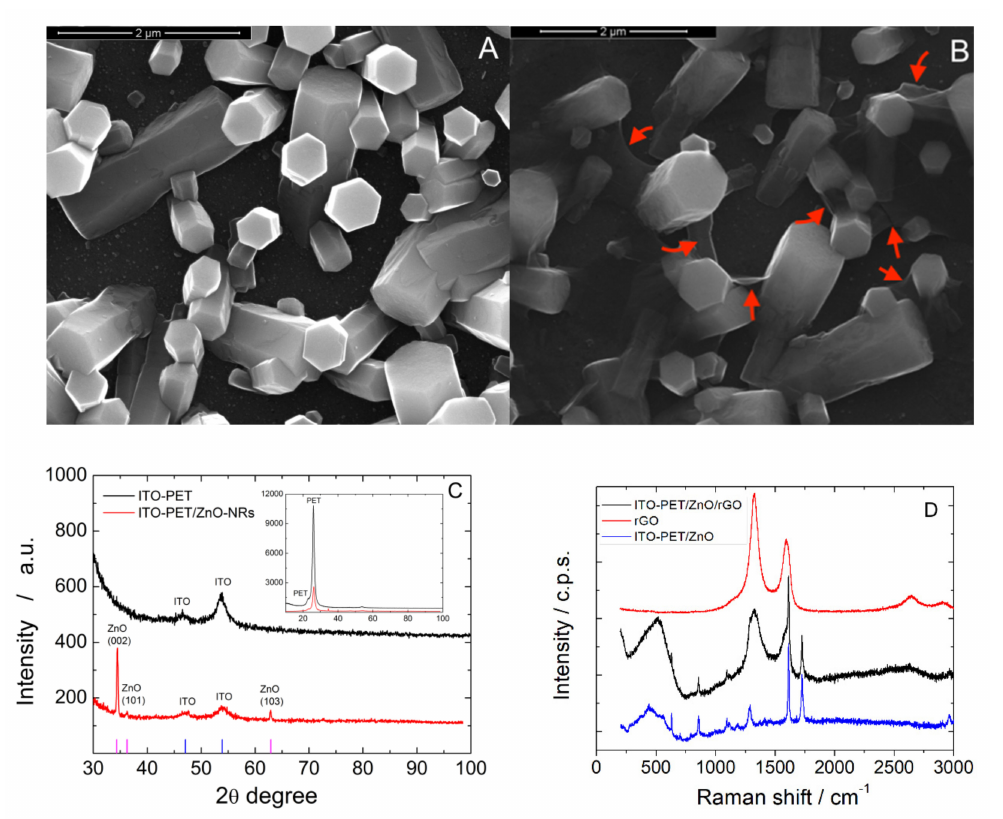
Figure 7. ( A , B ) FESEM images ( A ) before and ( B ) after rGO deposition, ( C ) XRD patterns and ( D ) Raman spectra. The ZnO electrode was obtained at − 0.95 V vs. Ag/AgCl for 60 min in a de-aerated solution of 10 mM ZnCl2 and 10 mM NaNO 3 at pH